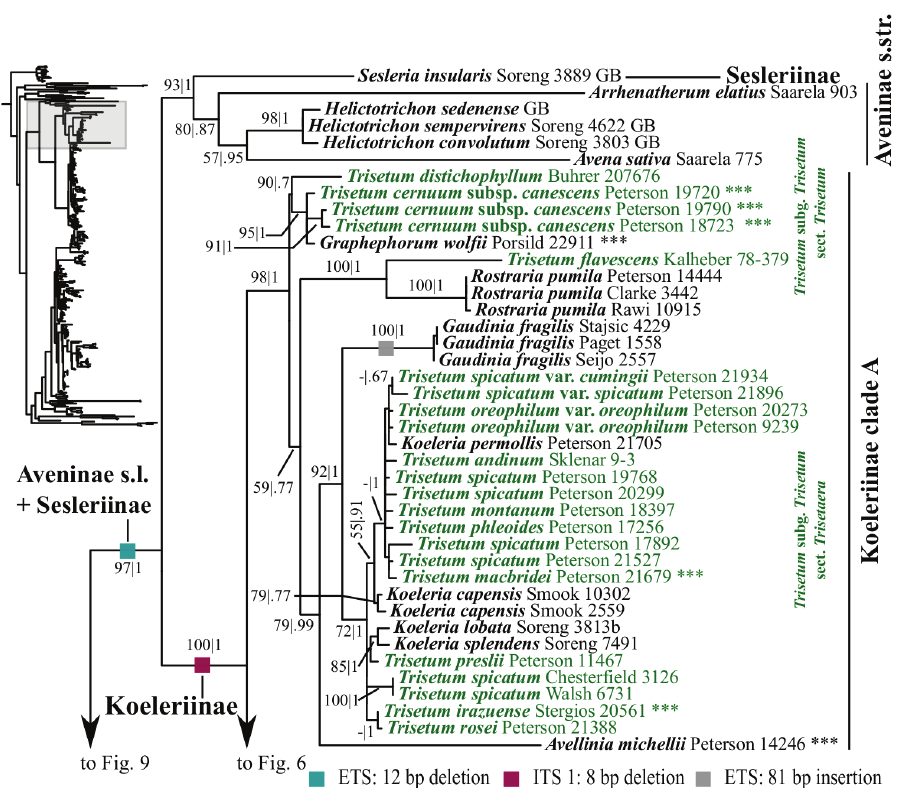
Figure 5. A portion (Sesleriinae, Aveninae s.str., Koeleriinae clade A) of the maximum likelihood phylo- gram inferred from ITS+ETS data. ML bootstrap support (left) and BI poster probabilities (right) are recorded along branches. A dash indicates bootstrap support <50%. No support is shown for branches with bootstrap support <50% and posterior probability <.5. The shaded area of the smaller tree on the left indicates the location in the overall tree of the portion shown. Placements of samples with asterisks (***) are incongruent in nrDNA and plastid trees. Two indels in ETS and one in ITS are mapped onto the